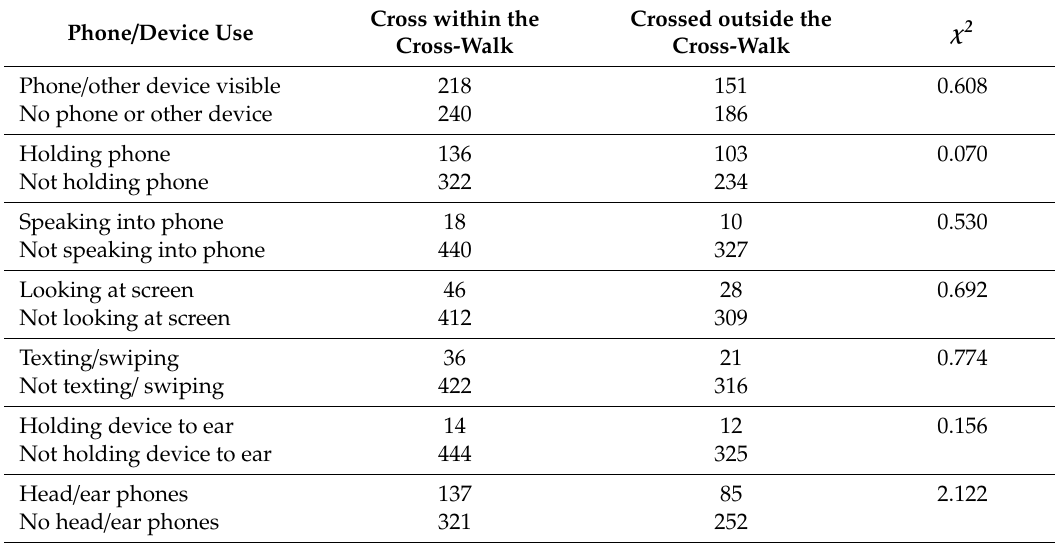
Table 3. Use of electronic devices in relation to road-crossing behaviours—cross-walk (number of road crossings).